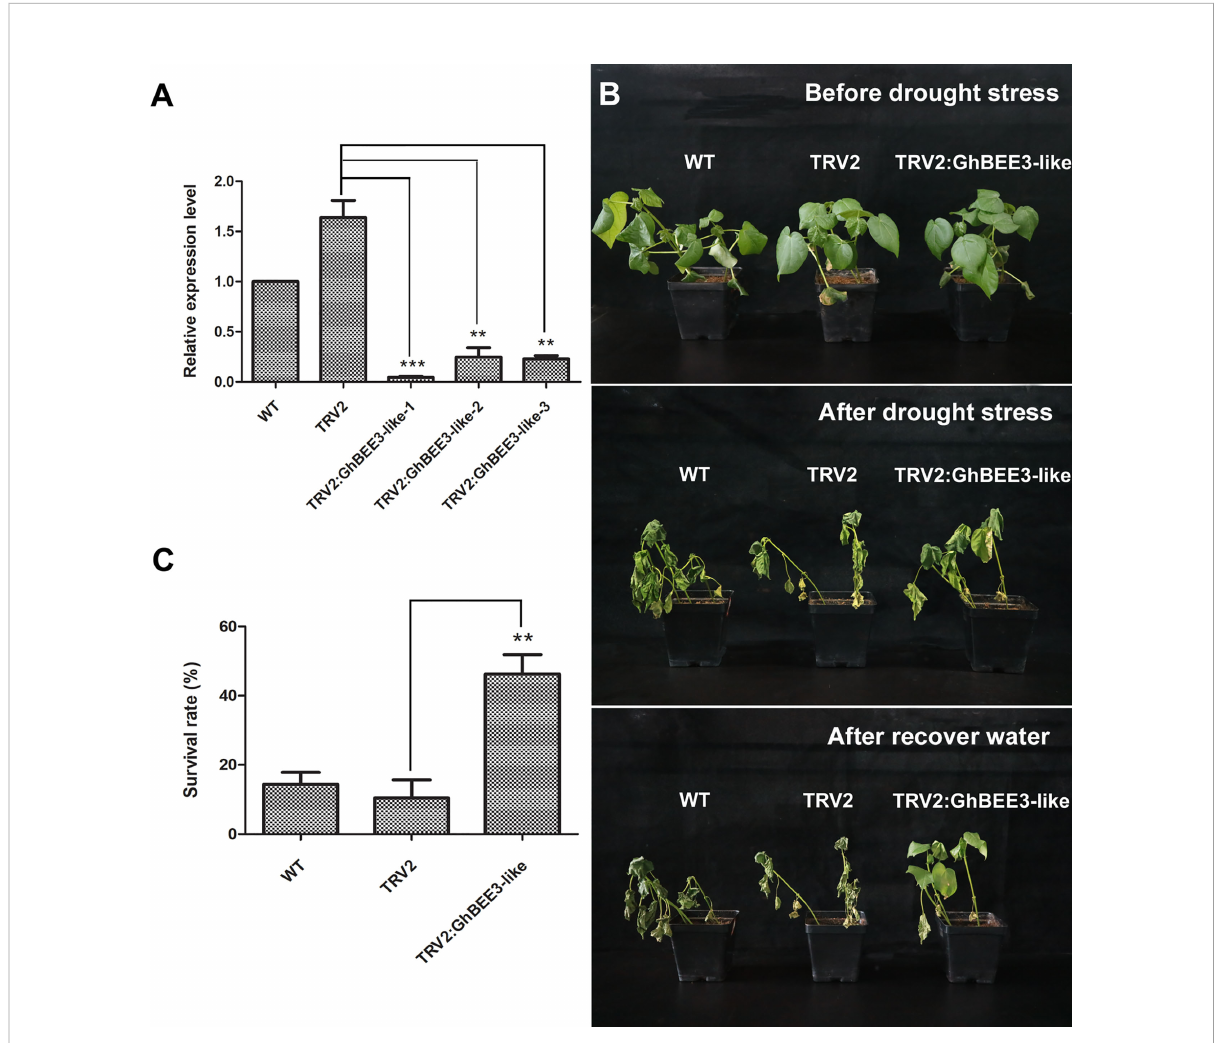
FIGURE 7 Responses of the WT, TRV2 (TRV2 vector transformation) and TRV2:GhBEE3-Like ( GhBEE3-Like gene knock-down) cottons to drought stress. (A) Expression analysis of GhBEE3-Like gene in the three cotton types by qPCR. Signi fi cant differences compared to the TRV2 cotton. Student ’ s t -test, ** P <0.01, *** P <0.001. (B) Phenotypic observations of the three cotton types before and after drought stress as well as after water recovery. (C) Survival rates of the three cotton types at the time of water recovery 7 days after drought stress. Error bars were obtained from three independent biological replicates. Means ± SD (n=30, Student ’ s t -test, ** P